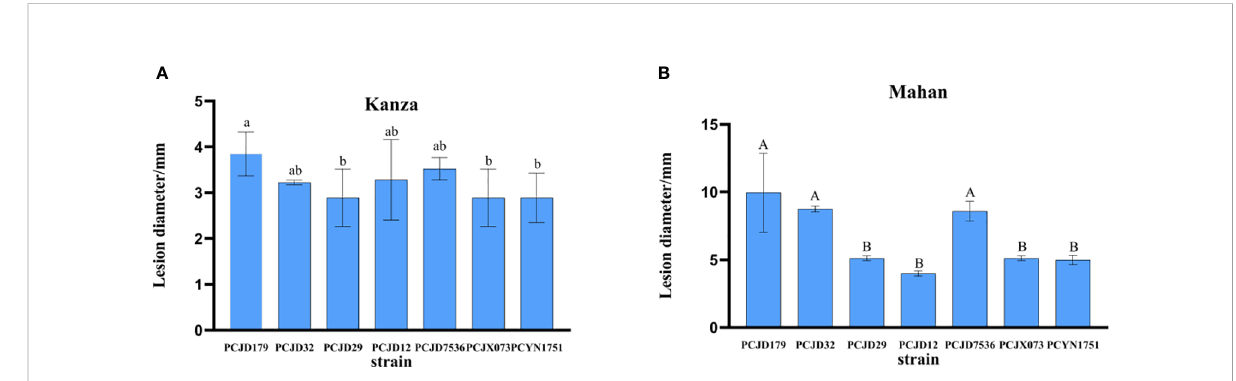
FIGURE 4 Lesion lengths on wounded pecan leaves at 18 dpi with spore suspensions of seven Colletotrichum spp. Different lowercase letters above the error bars indicate signi fi cant differences at p = 0.05. Different capital letters above the error bars indicate signi fi cant differences at p = 0.01. (A) ‘ Kanza ’ ; (B) ‘ Mahna ’